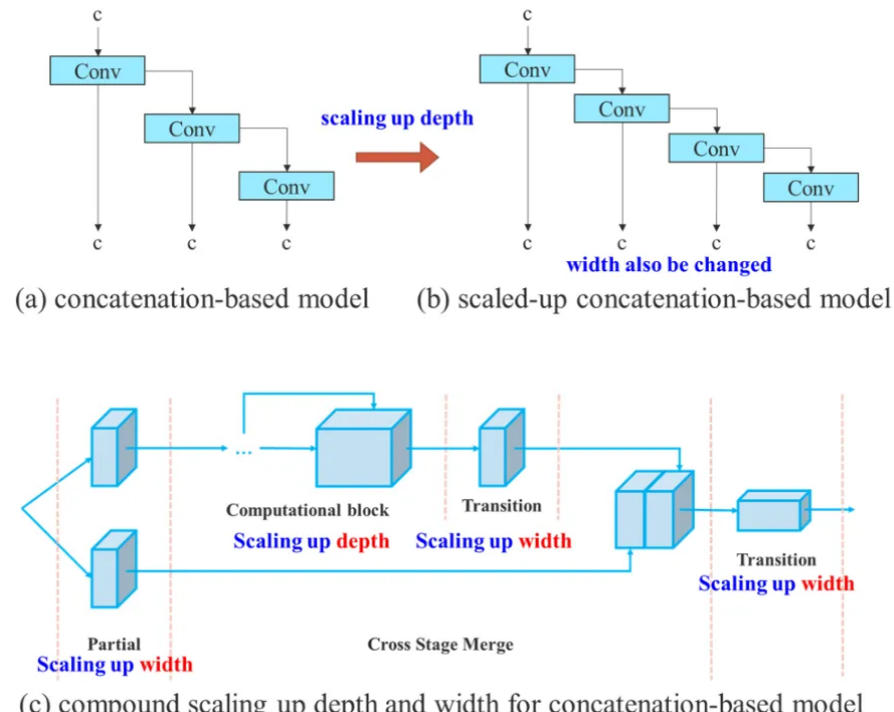
Figure 13. Illustrating of model scaling for concatenation-based models [9].